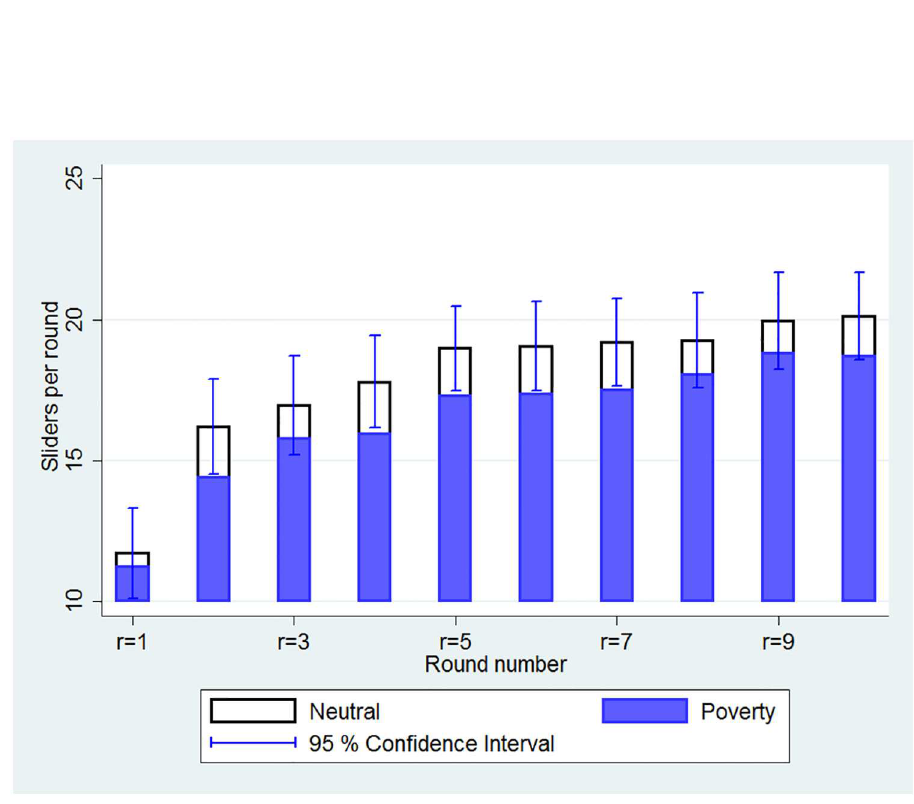
Fig 2. Average performanceby round and